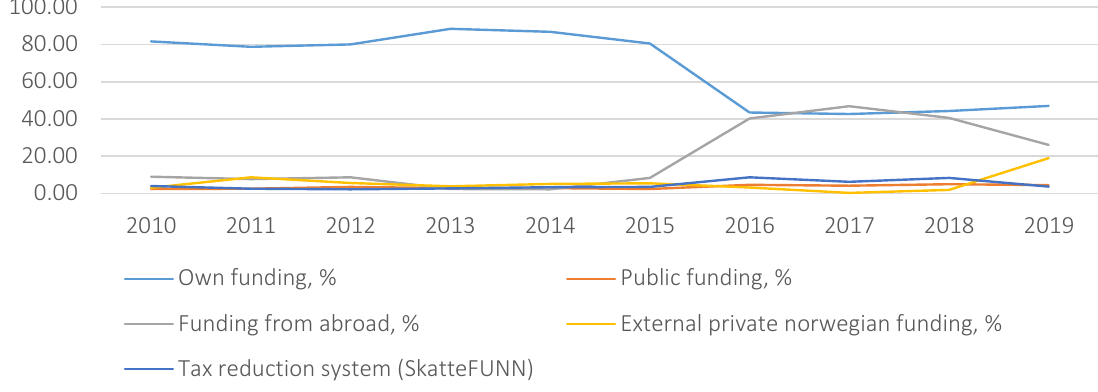
Figure 5. Funding of BERD in Building of ships and boats, % of total